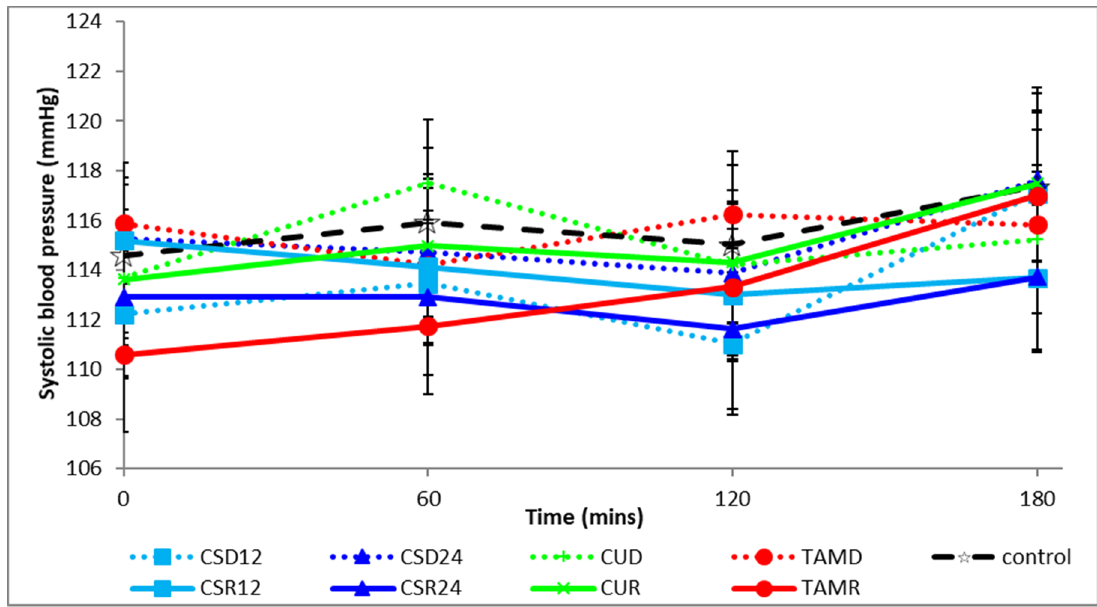
Figure 4. Postprandial changes in systolic blood pressure during various treatments. corn silk drink 12 g; CSR12: corn silk rice 12 g; CSD24: corn silk drink 24 g; CSR24: corn silk rice 24 g; CUD: cumin drink; CUR: cumin rice; TAMD: tamarind drink; TAMR: tamarind rice.